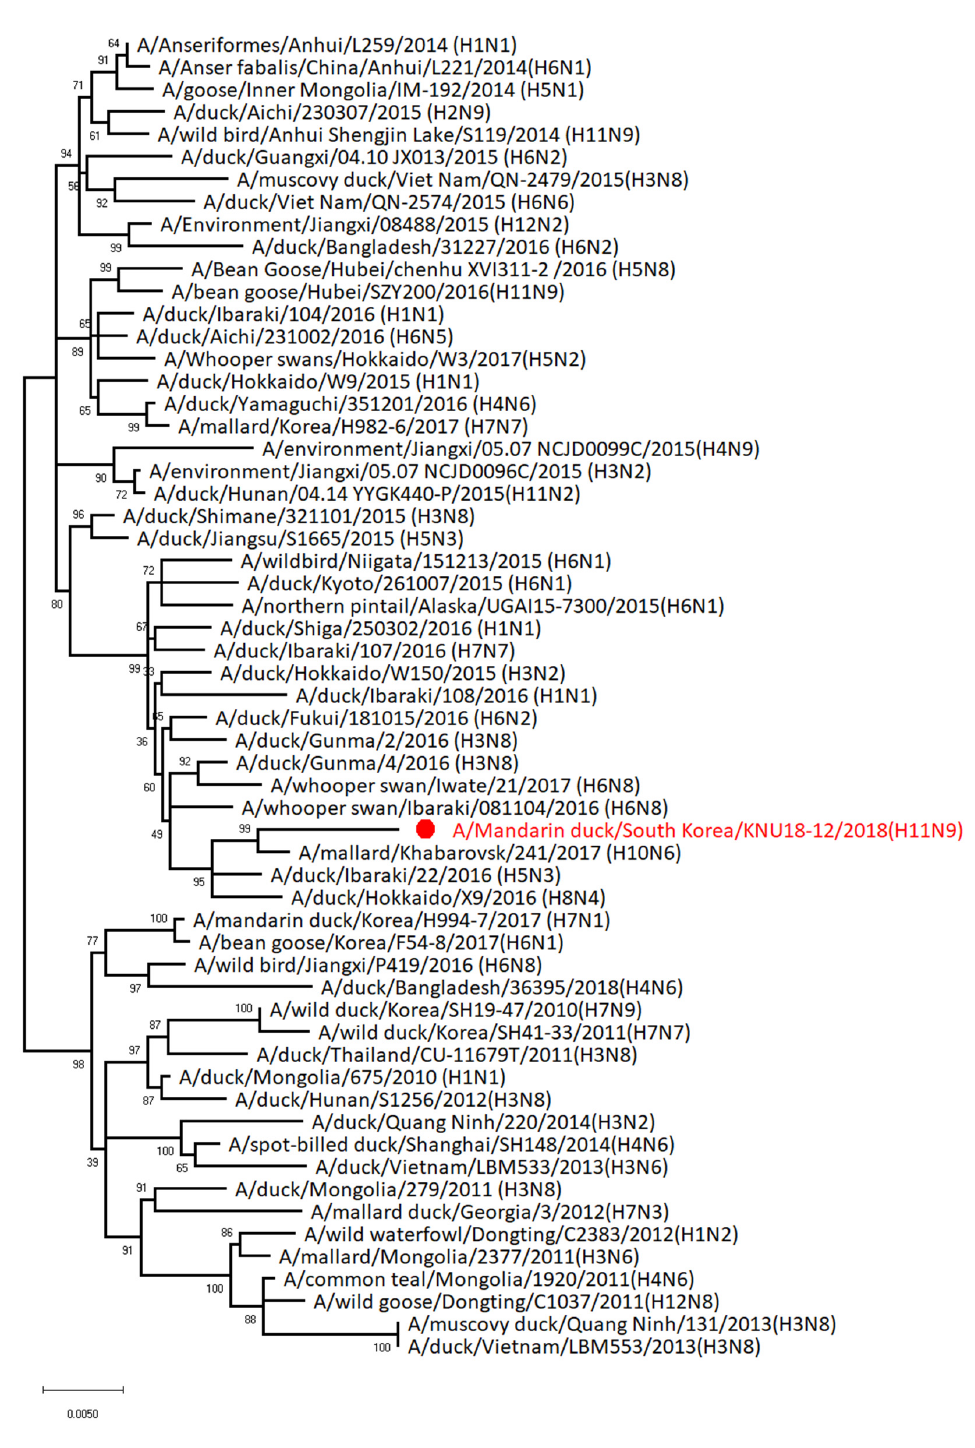
Figure 2. Phylogenetic tree based on nucleotide sequences of HA ( a ), NA ( b ), M ( c ), NP ( d ), NS ( e ), PA ( f ), PB1 ( g ), and PB2 ( h ). The tree was generated by the neighbor-joining method with MEGA 6.0 software using bootstrap replication (1000 bootstraps). Our isolate (A / Mandarin duck / South Korea / KNU18-12 / 2018(H11N9)) is indicated by a red color and A / waterfowl / Korea / S353 / 2016 (H11N9), a previous H11N9 isolate in Korea, is indicated in blue. The Japan virus and origin strain of the Japan strain are shown in orange and green, respectively.